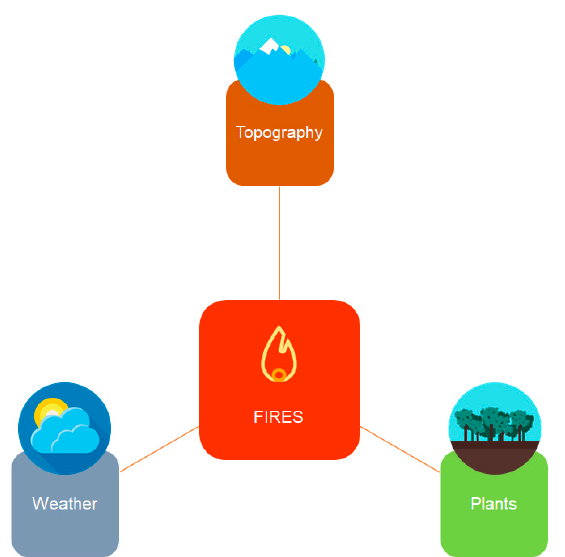
Figure 1. The ‘fire triangle’: fire risk assessment must account for the characteristics of all three elements. This representation illustrates a situation without human influence, which also affects fire risk.